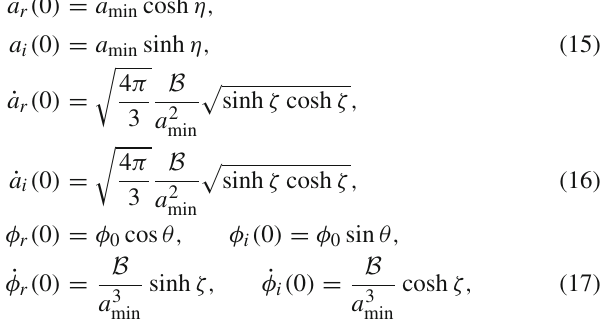
Figure 1 is an example for the chaotic inflation model V ch . For √ 3 / 4 π , φ 0 = 0 . 51, and ζ = 0 . 001, the initial condition B = there exists a turning time X that satisfies a i → 0 as t → ∞